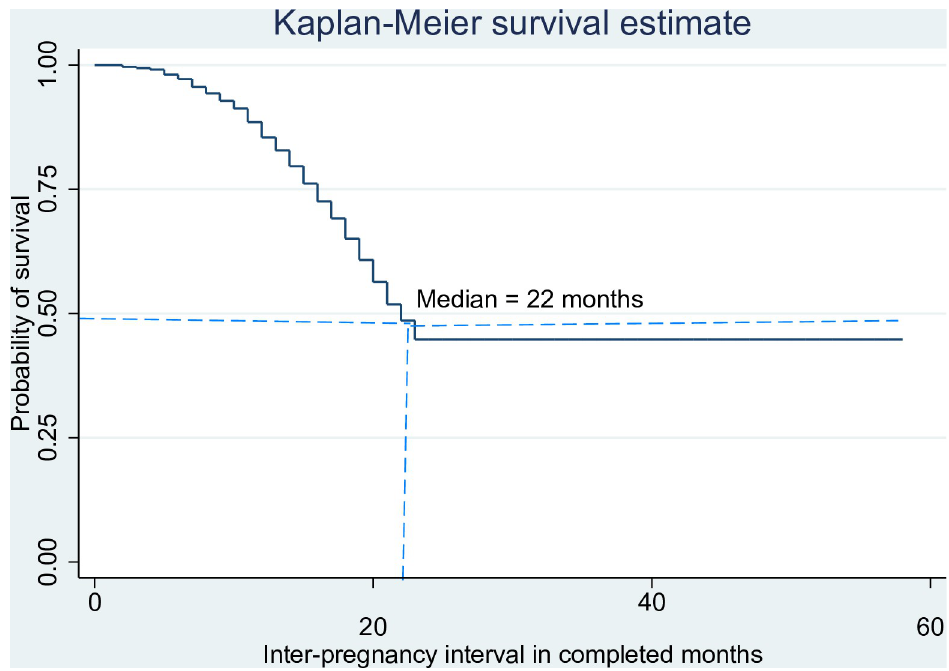
Fig 1. Cumulative survival time to pregnancy in completed months among pregnant women in urban South Ethiopia,